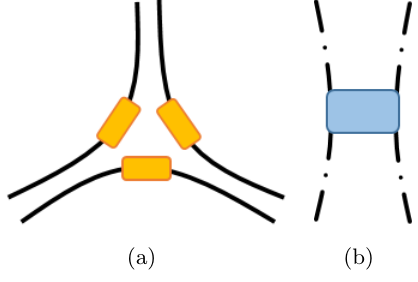
Figure 38 . (a) Tensor T and (b) Tensor E for the tensor network with f 7 ; 3 g tiling and nh 1 i h 1 1 io S c = ; . 3 1 1